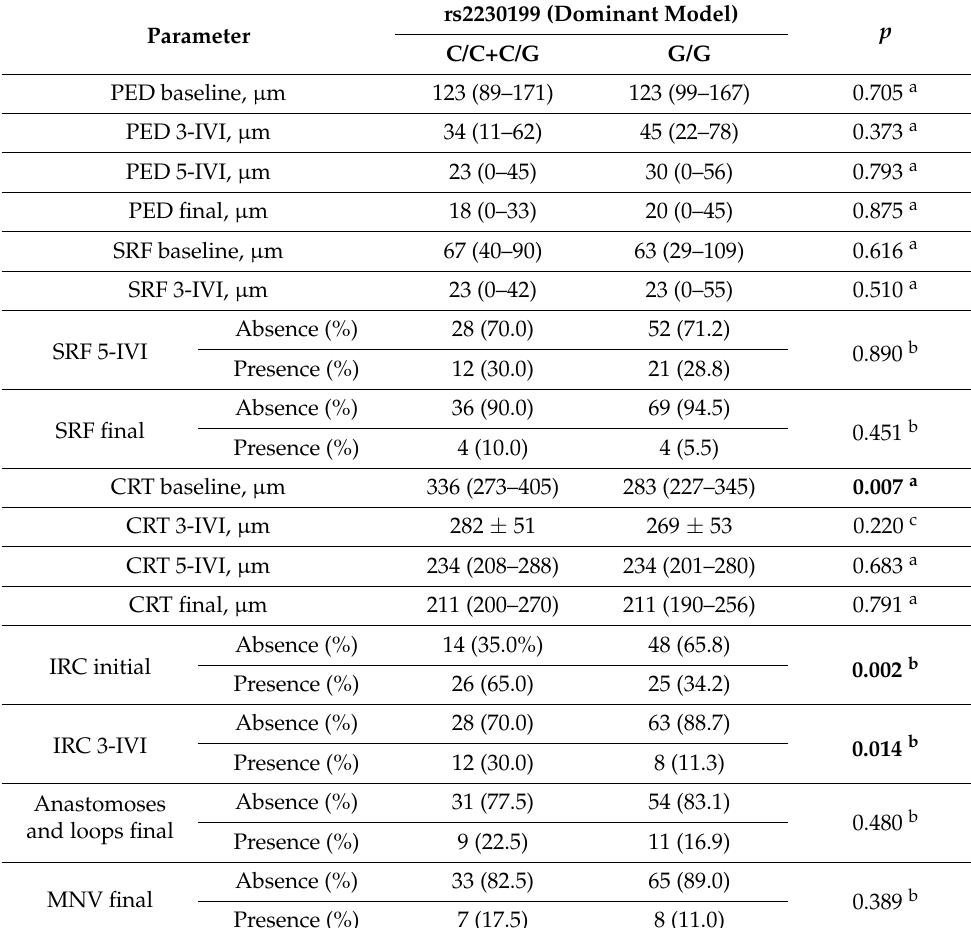
(Table 7). Thus, in T/T carriers of the rs2285714 CFI genotype, recurrence of MNV was recorded significantly more frequently by the end of the follow-up. In patients with the protective allele rs800292 CFH, the SRF height after 3-IVI was lower than in patients with the risk G/G genotype ( p = 0.04). Despite the low frequency of the protective A/A genotype rs800292 (CFH), it is worth noting that in all these patients, no IRCs were detected at baseline and there was no MNV activity after three loading doses of IVI. Associations of rs2230199 with the baseline CRT and the IRC were revealed (Table 8). The baseline CRT was higher in carriers of the C allele of rs2230199 ( p = 0.007). The patients homozygous for the G allele rs2230199 had significantly lower odds of IRC at baseline (OR = 0.280; 95% CI: 0.125–0.630) and after 3-IVI (OR = 0.296; 95% CI: 0.109–0.805). Table 8. Analysis of the OCT biomarkers depending on the